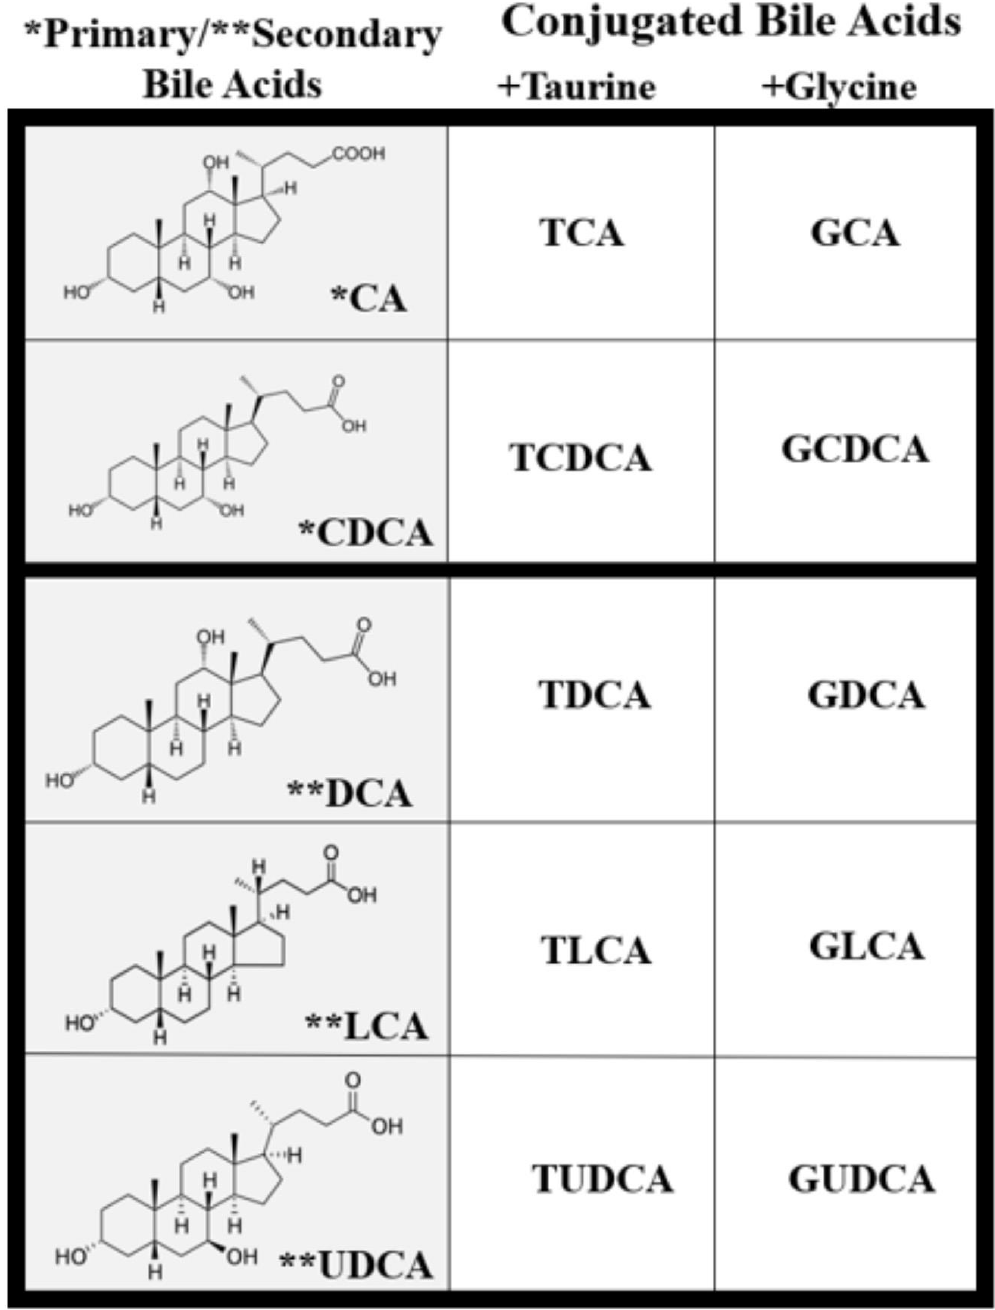
Figure 2. Types of unconjugated and conjugated bile acids. Primary and secondary BAs are either taurine or glycine conjugated to form primary and secondary conjugated BAs.